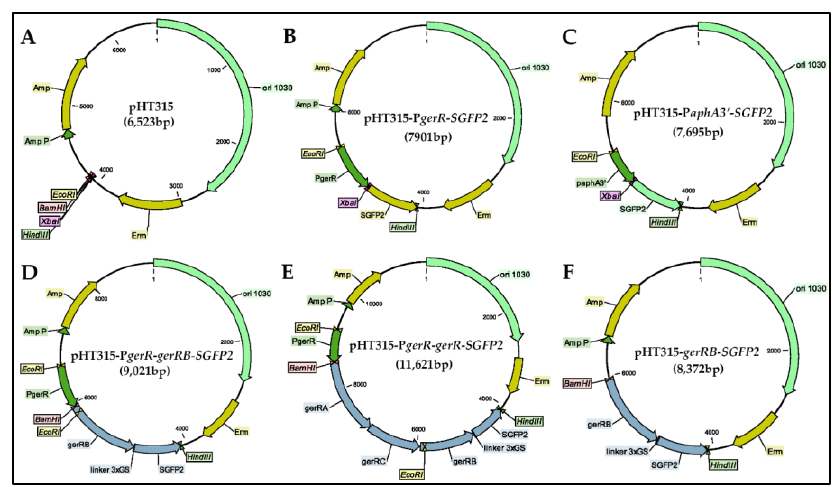
Figure 1. Schematic diagram of the recombinant plasmids. ( A ) pHT315; ( B ) pHT315-P gerR - SGFP2 ; ( C ) pHT315-P aphA3′ - SGFP2 ; ( D ) pHT315-P gerR - gerRB - SGFP2 ; ( E ) pHT315-P gerR - gerR -SGFP2; ( F ) pHT315- gerRB - SGFP2 .